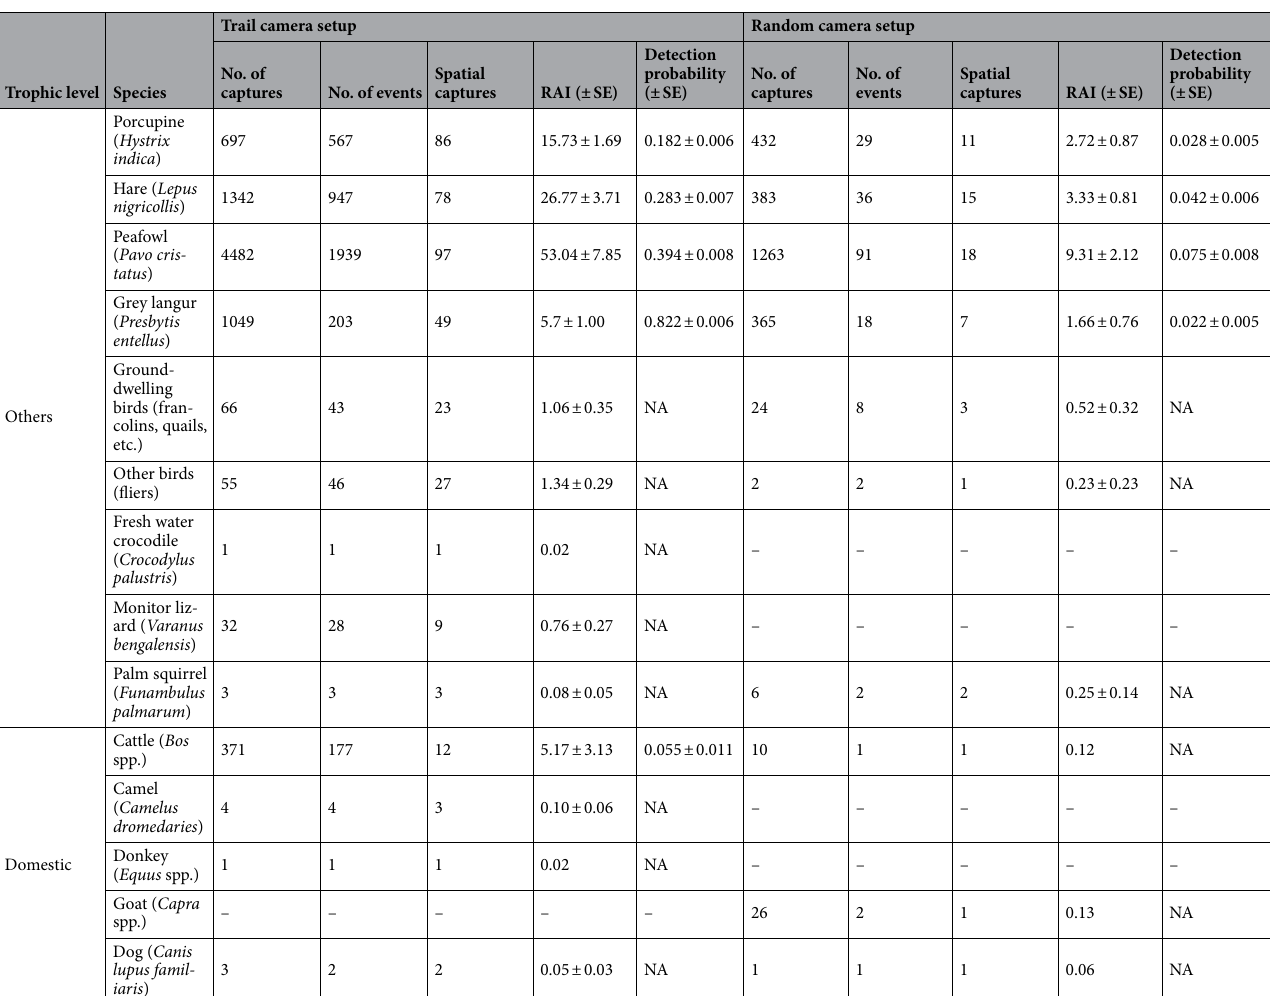
Table 1. Number of species photo-captured, individual events, number of locations they were captured in (spatial capture), relative abundance index (RAI = 100 * Number of individual events/total effort), and detection probability (from occupancy analysis) obtained from trail (n = 106) and random (n = 31) camera setups. SE standard error, NA estimates not available.